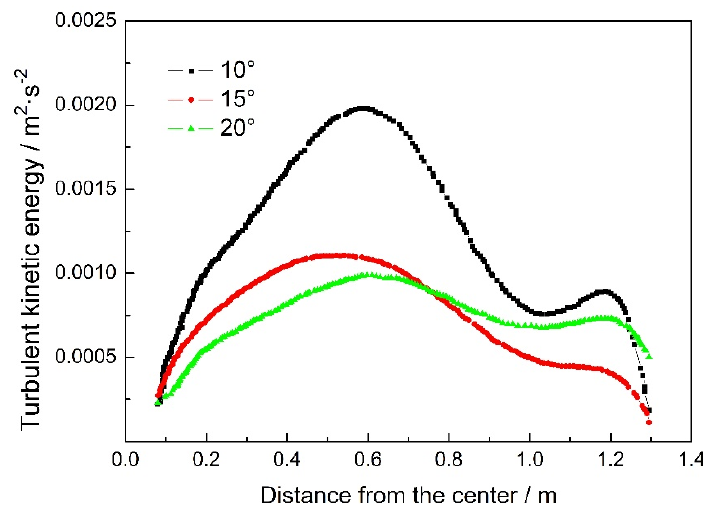
Figure 5. Influence of the SEN angle on the turbulent kinetic energy at free surface. Table 3. Upper and lower flow vortex core position.